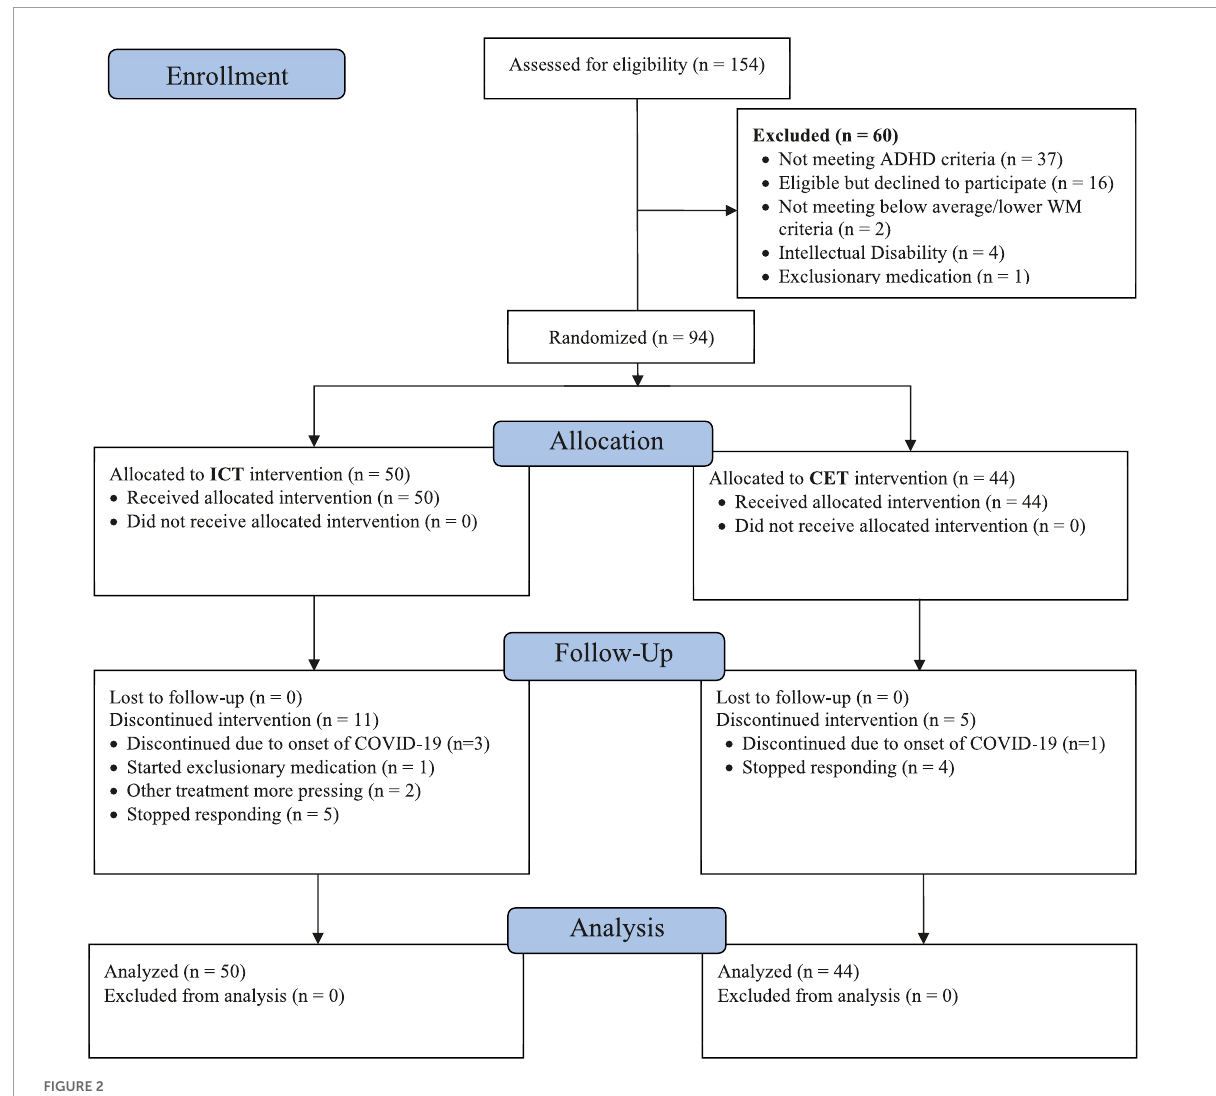
FIGURE2 CONSORT diagram. The 154 children assessed for eligibility include all children recruited for evaluation in our research clinic during the study timespan, regardless of recruitment reason (because families would have been offered the intervention trial if their child was diagnosed with ADHD and otherwise eligible). The number of confirmed ADHD cases who were considered for eligibility is 112, of whom 94 (83.9%) were randomized and